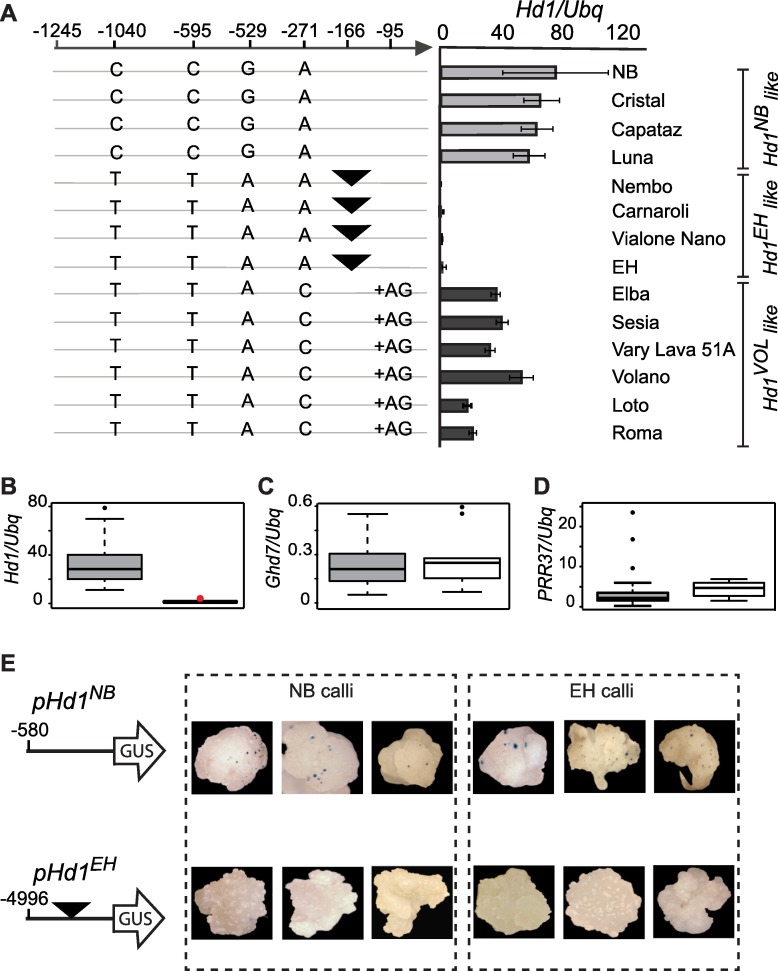
A mobile element suppresses transcription of Hd1.A, Comparison of the Hd1 promoter haplotypes among 13 varieties belonging to the ERCC and Nipponbare. All varieties harbored functional alleles of Ghd7, Ghd8 and PRR37 (except EH). The position of each polymorphism is indicated relative to the ATG. The black triangle corresponds to the position of the mobile element (not drawn to scale). Varieties are clustered based on the presence of distinct alleles at the Hd1 locus, including Hd1NB, Hd1EH and Hd1 from Volano (Hd1Vol), a widely cultivated, temperate japonica variety from Italy. Graphs on the right show Hd1 expression under LD (16L/8D). Error bars indicate the standard deviation. b-d, Box plots showing expression levels of Hd1 (B), Ghd7 (C) and PRR37 (D) quantified in 4-week-old seedlings of 102 accessions (“functional” varieties described in [23]) grown under 16h LD and distinguished based on the presence of the mobile element (gray: without mobile element, 38 varieties; white: with mobile element, 64 varieties). A single accession, Real, was heterozygous for the insertion of the mobile element (red dot). E, Expression assays in scutellum-derived calli transformed with an Hd1NB or Hd1EH promoter driving expression of a GUS reporter. Three representative calli are shown. For each condition, 20–25 calli were transformed and the experiment was repeated twice.